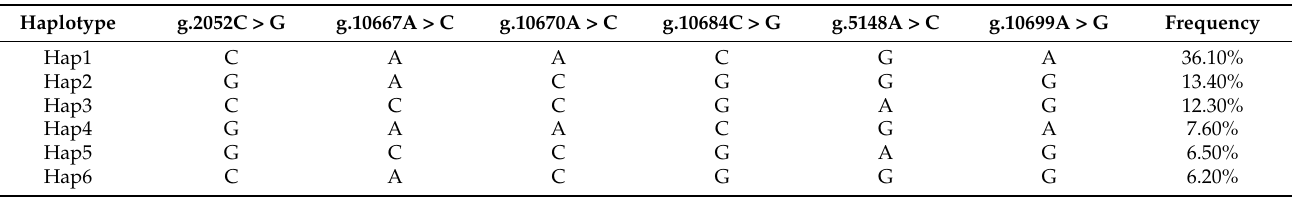
Table 5. Haplotypes analysis of the six SNPs in GHRHR